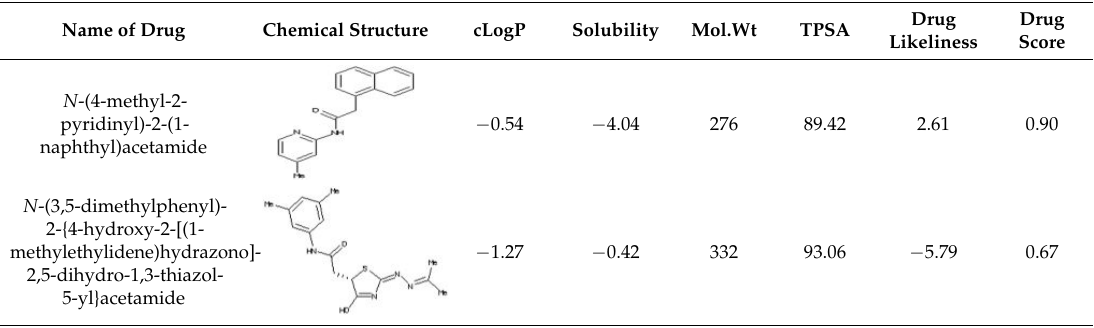
Table 3. The drug score and very significant parameters study of the six non-toxic ligand molecules. The molecule has been chosen for docking indicated in